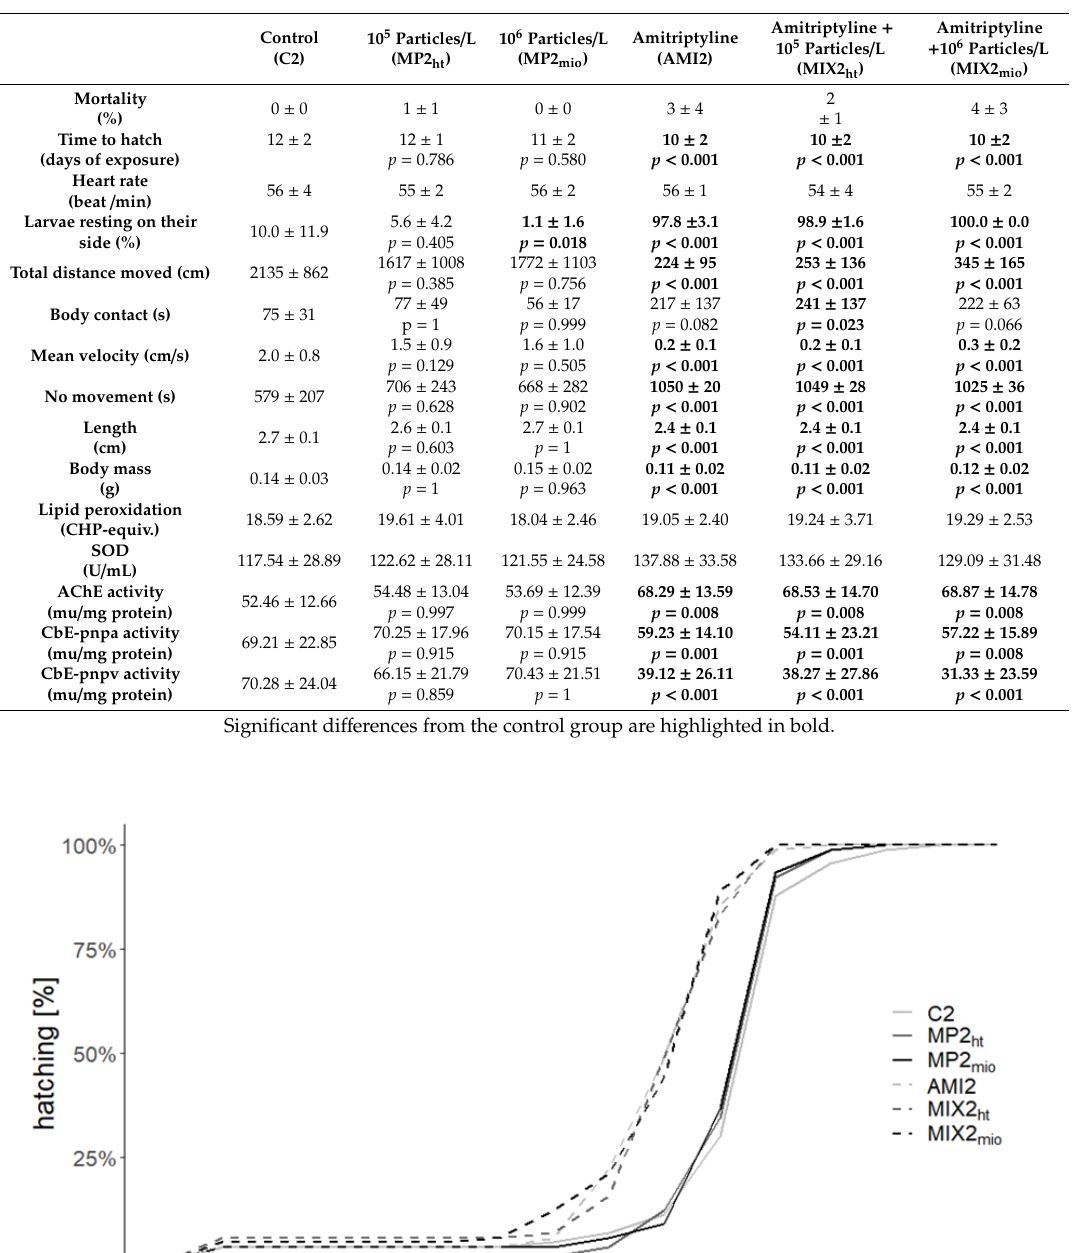
Table 4. Summary of data for the investigated endpoints in experiment 2. All data are given as arithmetic means ± standard deviation. p -values in comparison to the control group are given if significant di ff erences occurred.